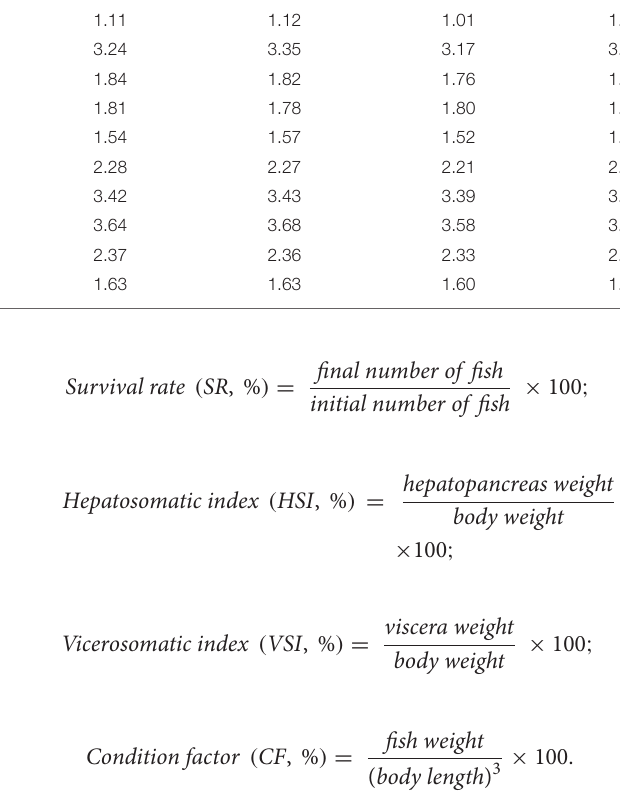
TABLE 2 | Essential amino acid (EAA) profile (%) of the test diets used in the experiment. Amino acids Test diets FM COS0 COS0.2 COS0.4 COS0.6 COS0.8 COS1